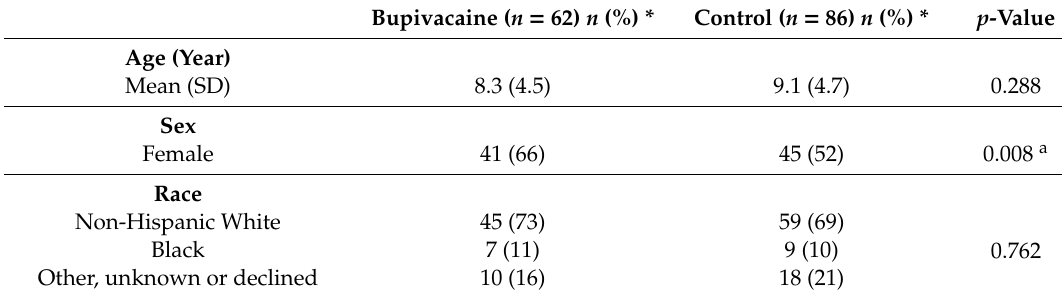
Table 1. Patient demographic